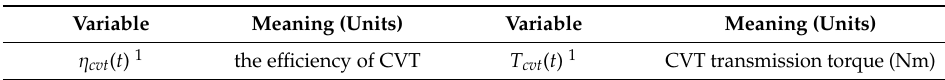
Table 5. CVT model